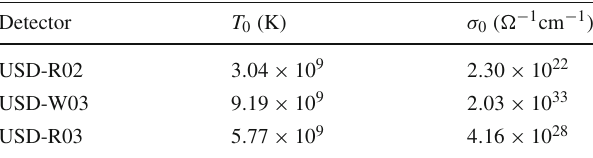
Fig. 6 The variation of conductivity with temperature for detectors USD-R02, USD-R03 and USD-W03. The slope of the plot for USD- R02 is found to be − 234.2 and the Y-intercept is 51.5. Similarly, the slope for USD-R03 is found to be − 275.6 and the Y-intercept is 65.9. Likewise, the slope and the Y-intercept for USD-W03 are found to be − 309.6 and 76.7, respectively Table 3 The calculated values of characteristic temperature ( T 0 ) and conductivity prefactor ( σ 0 ) for three USD-fabricated